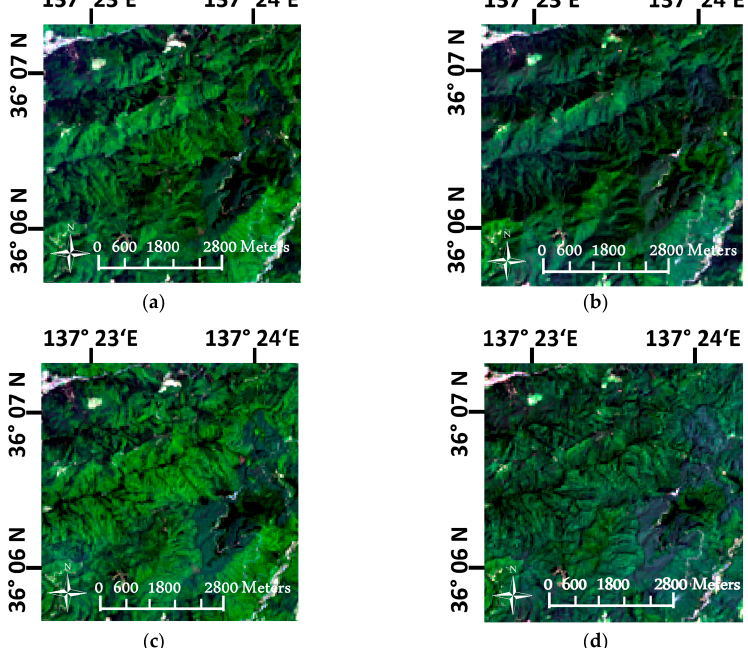
Figure 5. Mountainous area before ( a , b ) and after ( c , d ) topographic correction for sub-images dated 26 May 2013 ( a , c ) and 14 August 2013 ( b , d ); OLI bands 4, 3, and 2 correspond to red, green, and blue colors, respectively.